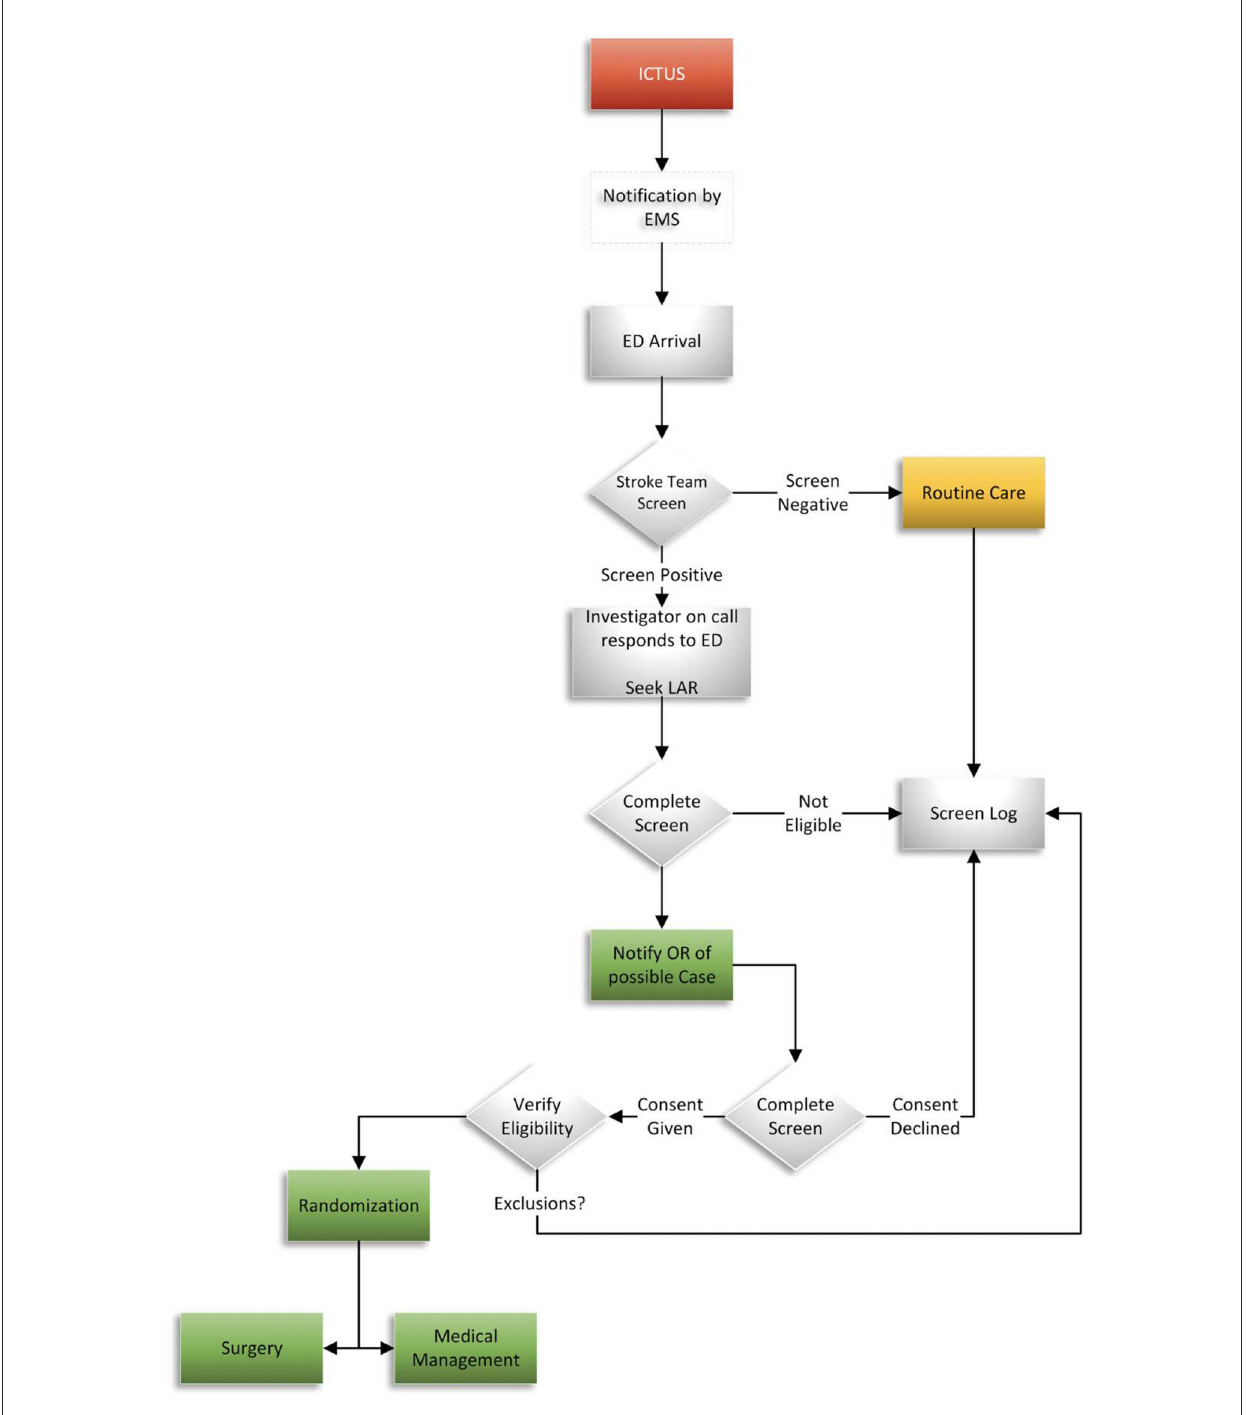
FIGURE2 Subject flow chart.